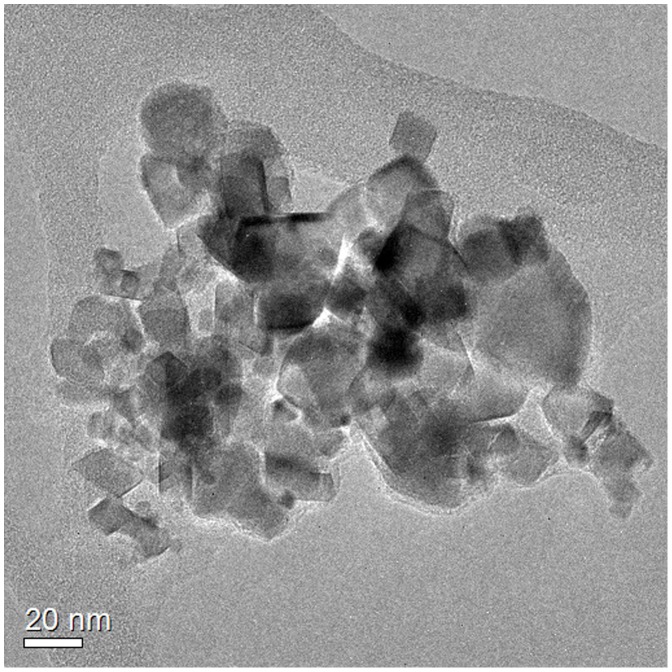
TEM bright field image of CeO2 NP after 24 h of stirring (5 mg/L, pH 7.6, 2 mM NaHCO3).